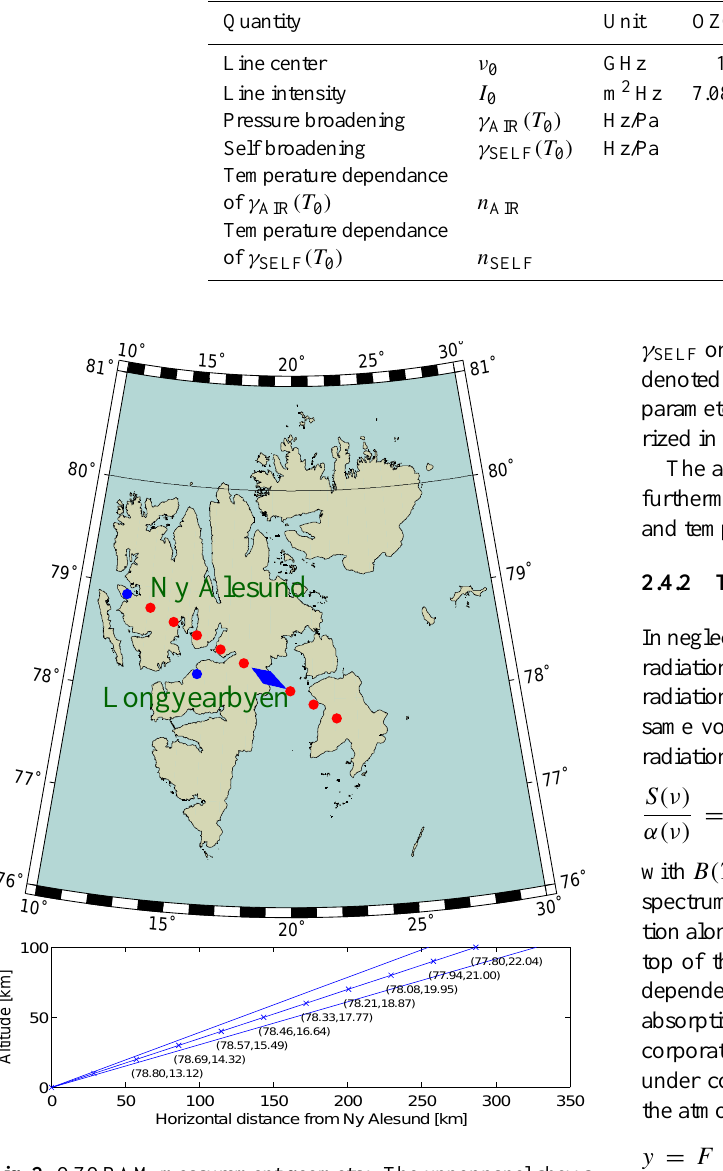
Fig. 2. OZORAM measurement geometry. The upper panel shows the ground track of the viewing path. The dots denote the viewing path in 10km steps. The diamond is the measured region of the at 60km altitude. The lower panel denotes the viewing path in the plane given by azimuth and zenith